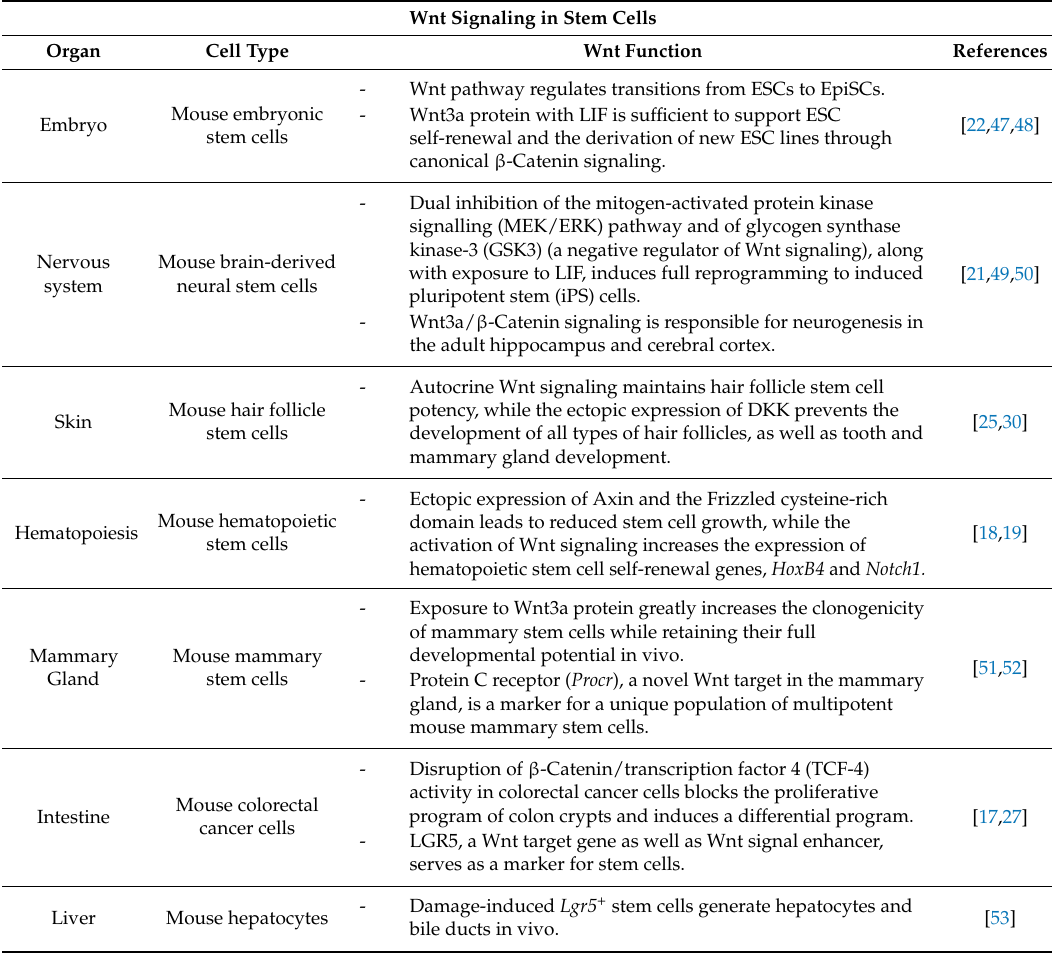
Table 1. Role of Wnt signaling in different cell